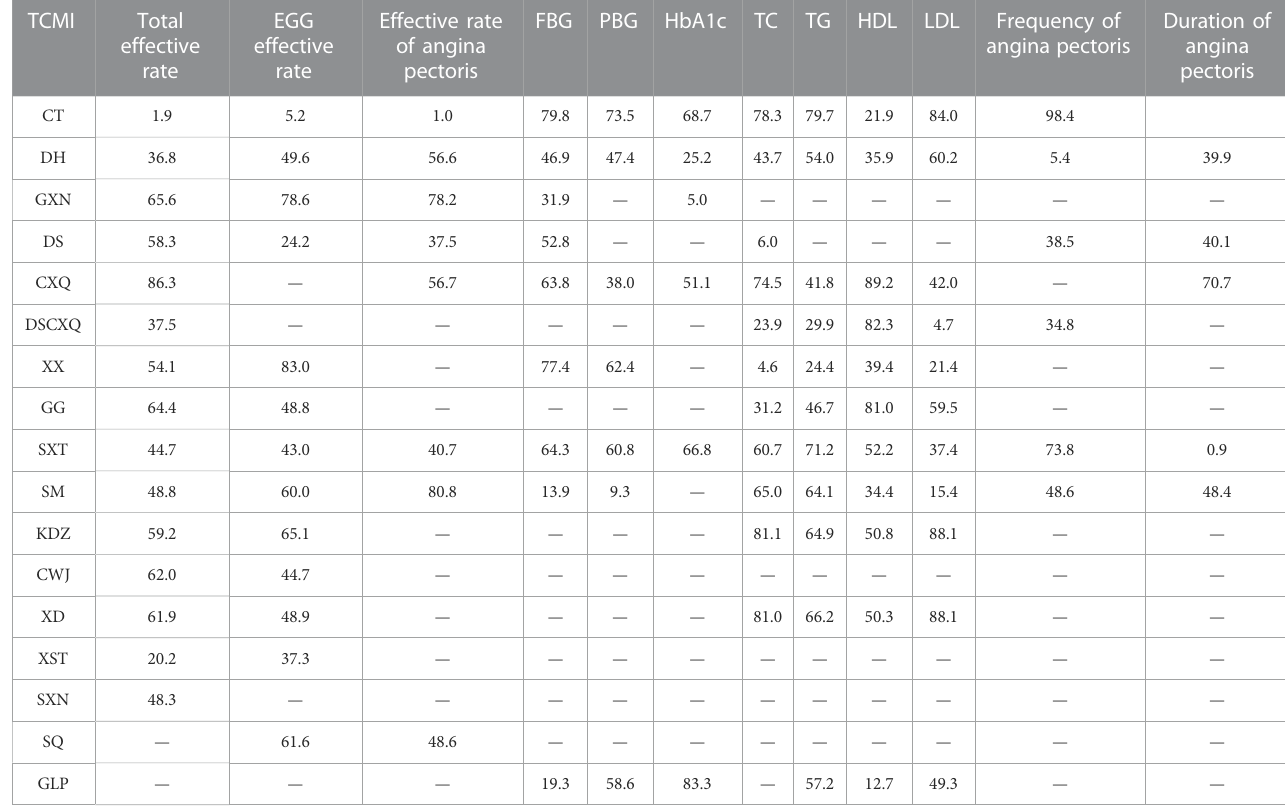
TABLE 2 SUCRA of different treatments for various